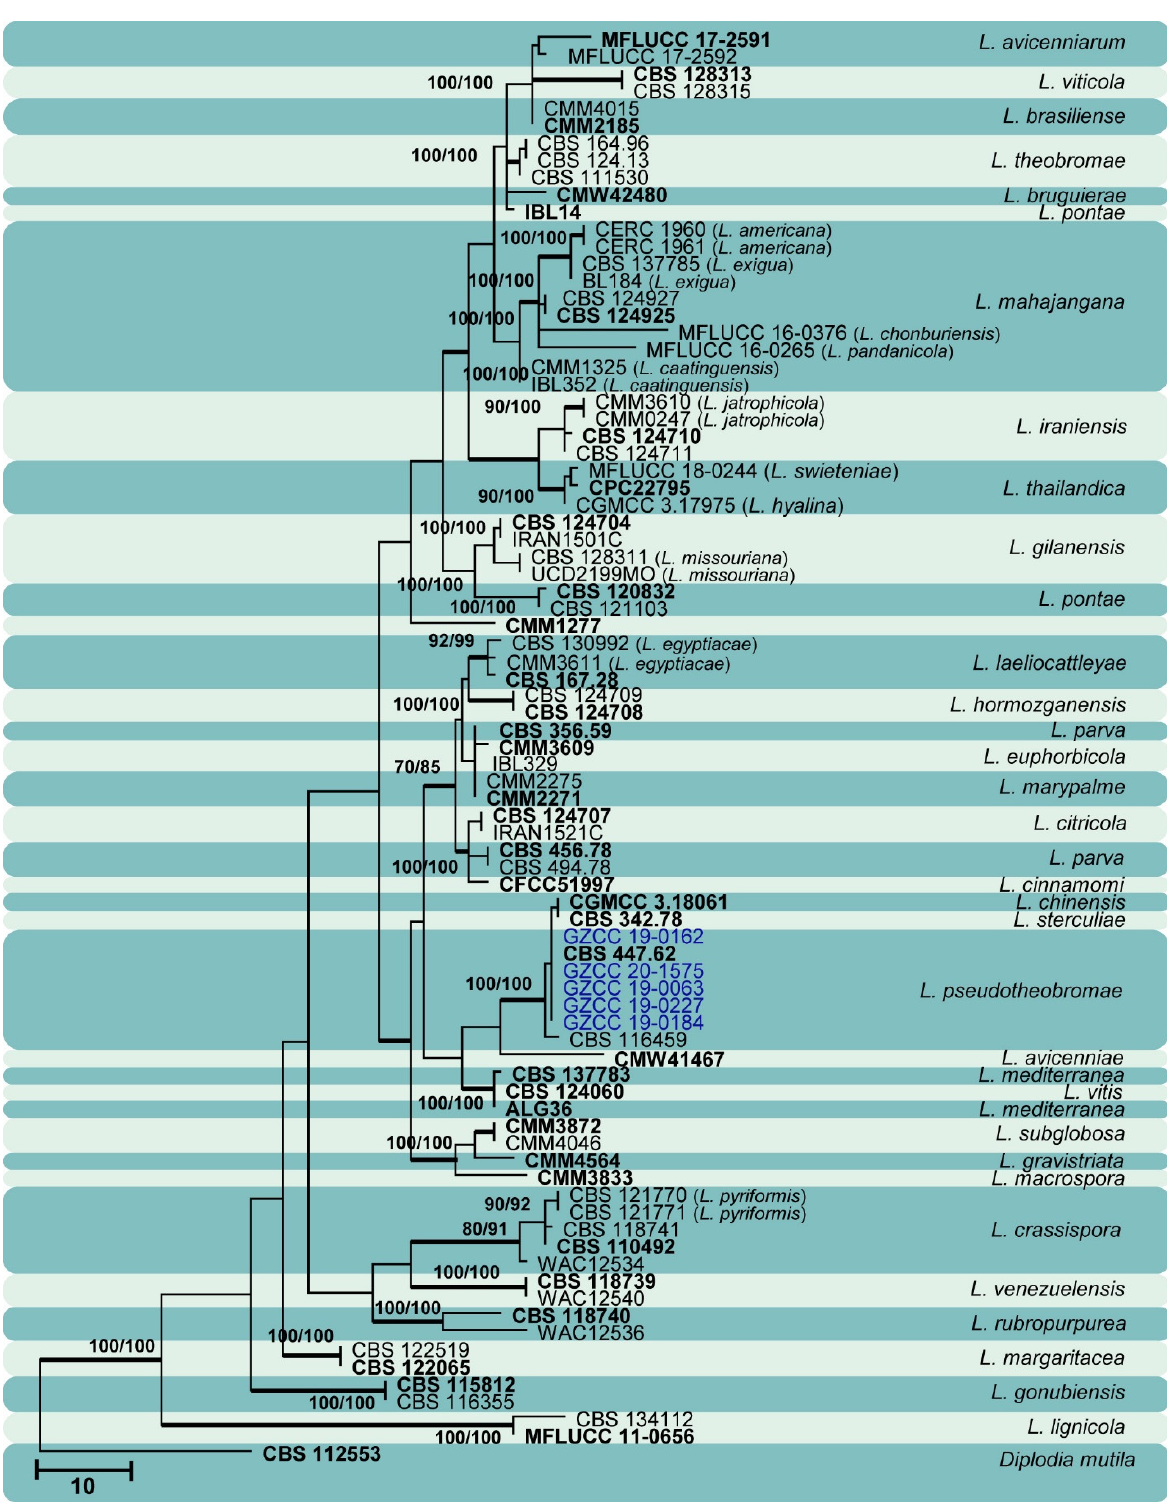
Figure 13. Maximum likelihood tree based on analysis of combined ITS and tef sequences of Lasiodiplodia . Bootstrap support values of ML, MP > 75% are shown near the nodes, and branches in bold indicate BI probabilities >0.95. Isolates obtained in this study are in blue for known species. Ex-type strains are in bold. The tree is rooted to Diplodia mutila (CBS 112553).